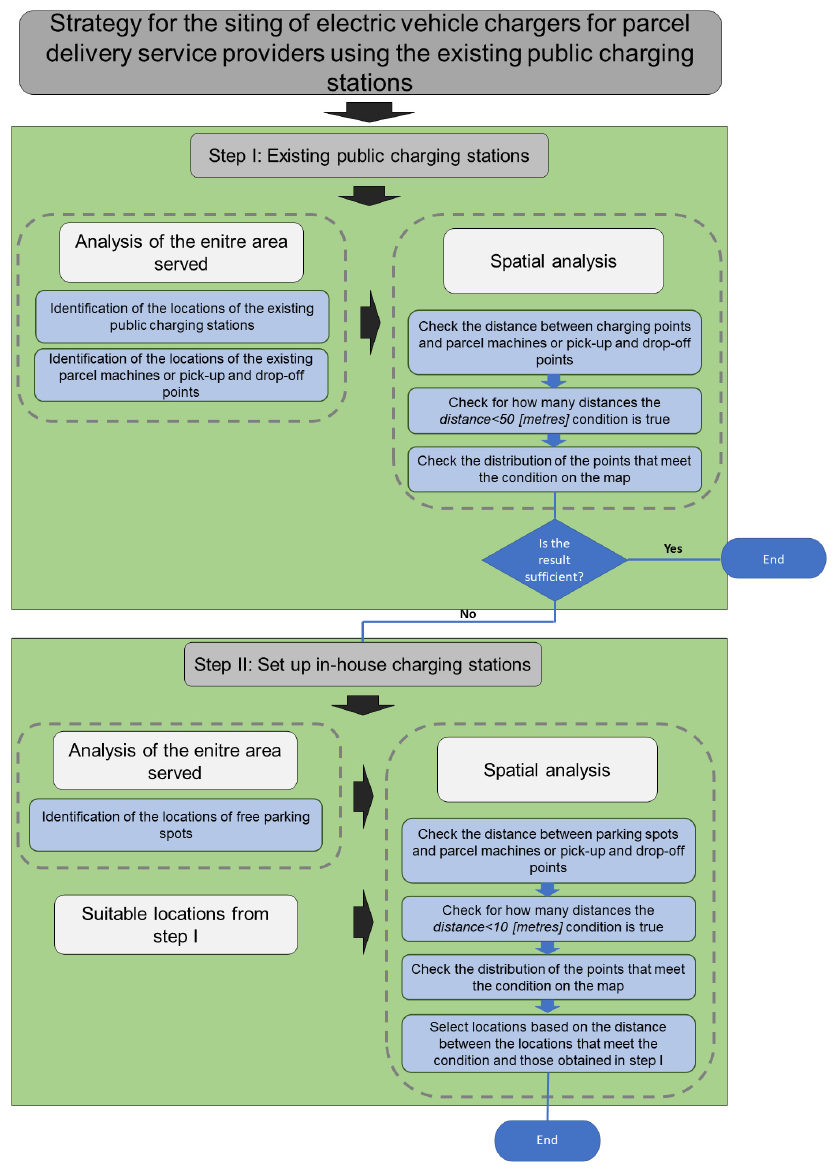
Figure 1. Diagram illustrating the first strategy for establishing potential electric vehicle charging sites for courier companies using the existing public charging infrastructure.